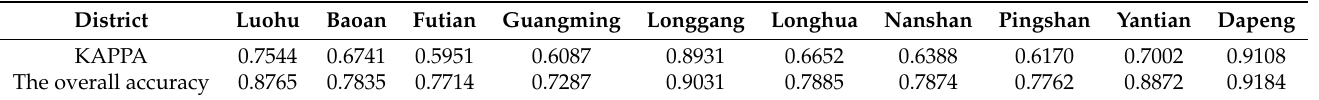
Figure 6. Forecast results of land use/land cover in Shenzhen in 2015 with the CA–Markov model. Then, we tested each district of Shenzhen separately. For the district of Shenzhen, the kappa coefficient and accuracy are shown in Table 3. Table 3. The Kappa and the overall accuracy of each district in Shenzhen using the diffusion